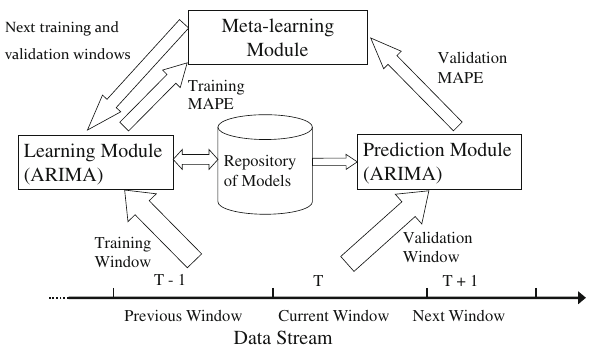
Fig. 1 Incremental OLIN learning with